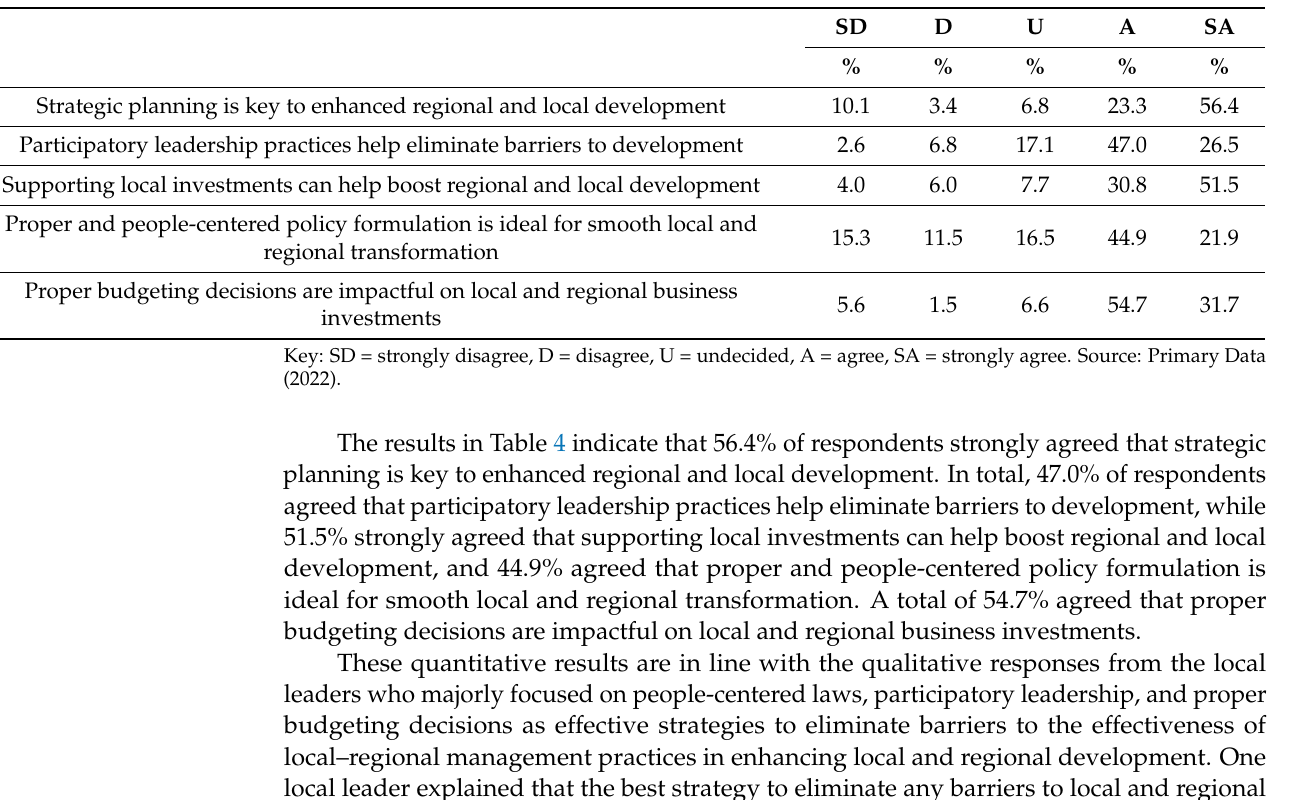
Table 4. Solutions to overcome barriers to the effectiveness of local–regional management practices in enhancing local and regional